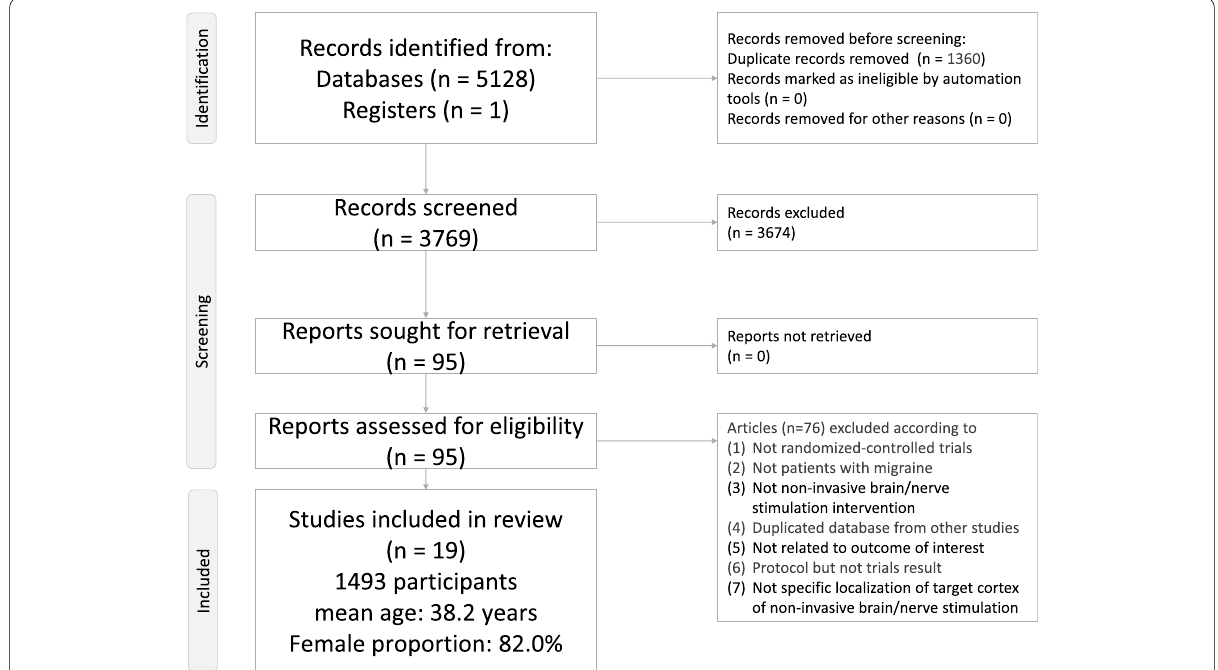
Fig. 1 Flowchart of the network meta‑analysis procedure. Flowchart illustrating the procedure of the present network